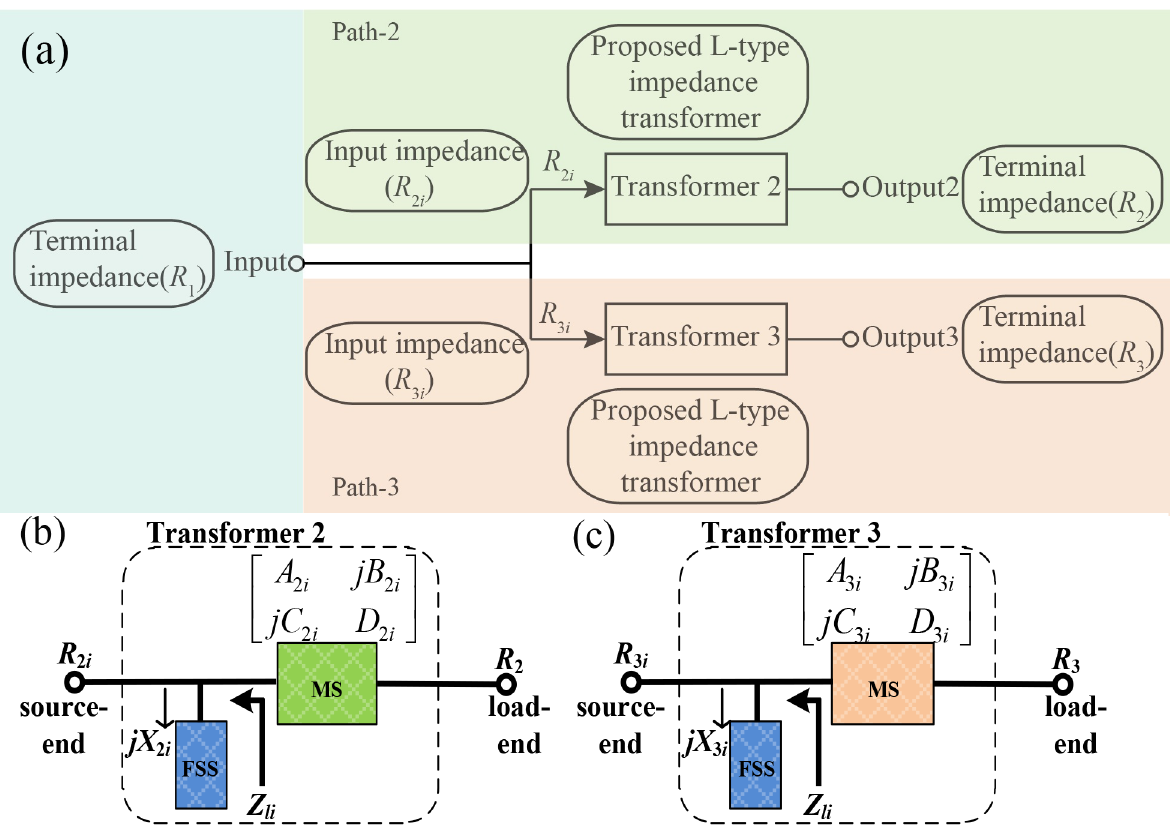
Fig 2. The topology of the TTPD. (a) Each path from the input port to the output port includesthe LN shown as Transformer 2 and Transformer 3 in this picture. R 1 ( R 2 and R 3 ) is the terminal impedance of the input (output) port, R 2 i and R 3 i are the equivalent input impedance calculatedin the direction from the input to the output in path-2 and path-3 at each specific frequency f i . The MS and the FSS of the L-type Transformer 2 (Transformer 3) are respectivelyexpressedby its ABCD-matrix and the equivalentinput impedance j X 2 i (j X 3 i ) in (b) and